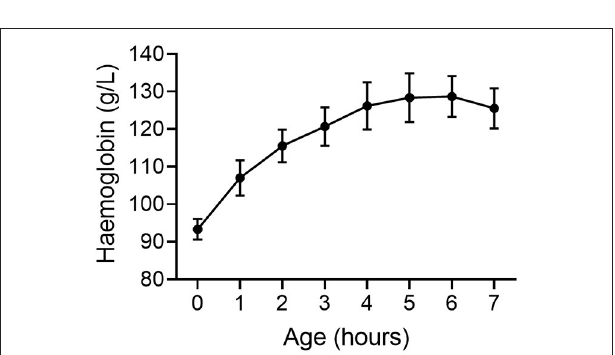
FIGURE 2 | Hemoglobin concentration increases following birth in very preterm piglets ( n = 10) suggesting a loss of plasma from the circulation and a reduction in blood volume ( 39). Mean ±